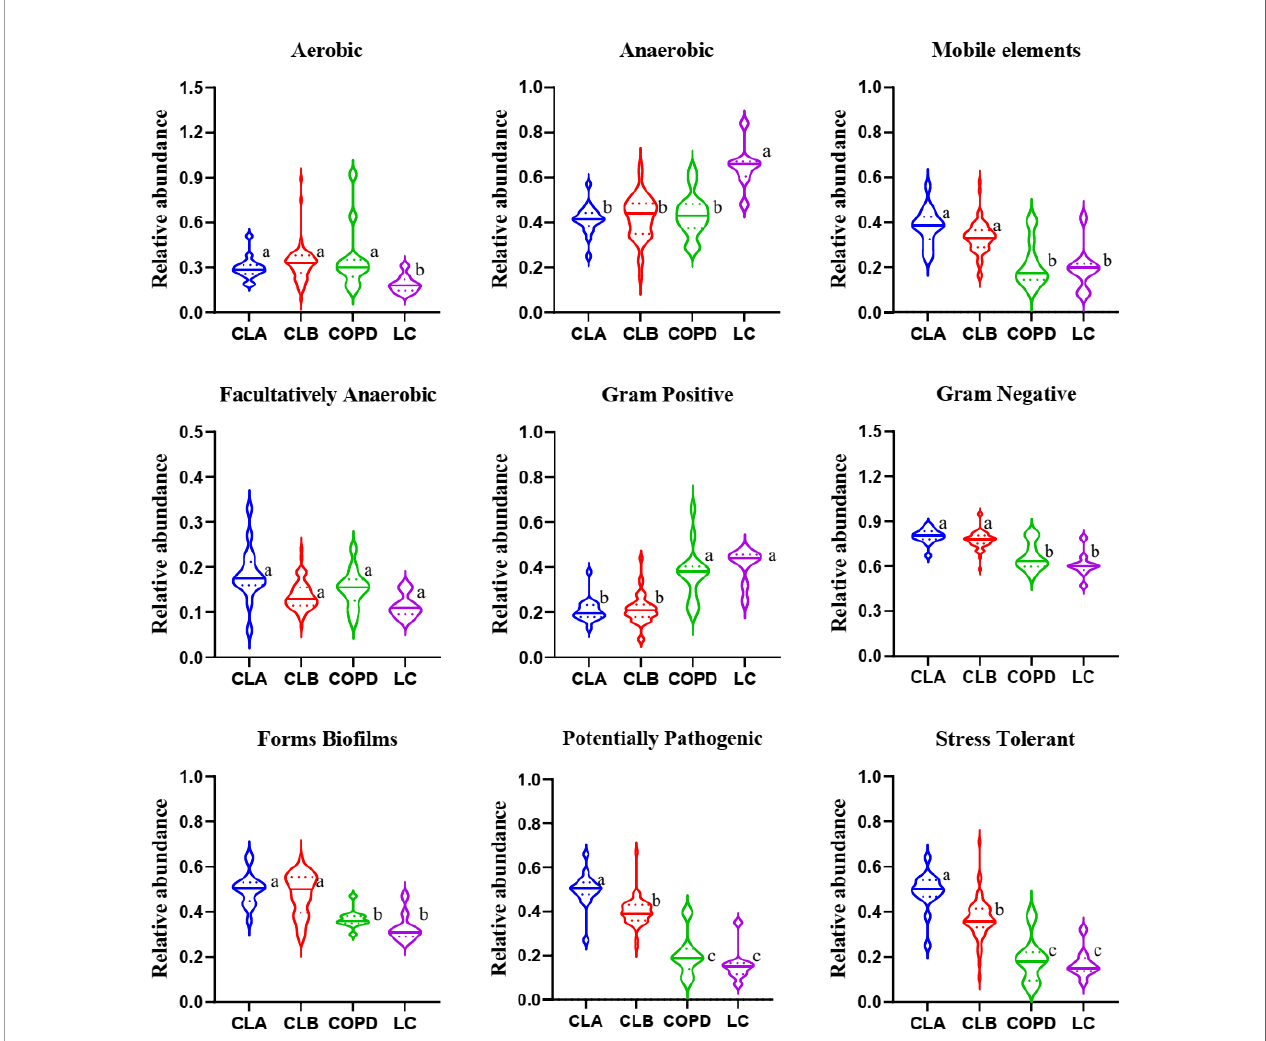
FIGURE 6 | Relative abundances of the main microbiota in the induced sputa of patients with non-small cell lung cancer (NSCLC). AD , patients with lung adenocarcinoma; SCC , patients with squamous cell carcinoma; Other , except AD and SCC, patients with other subtypes of NSCLC. Data shown are the median ± quartile. Different letters indicate statistically signi fi cant differences. p <